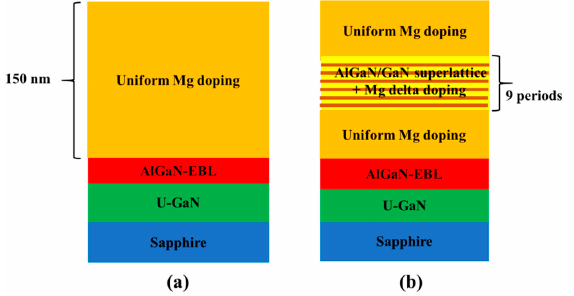
Figure 1. Structure diagrams of p-GaN: ( a ) sample A and ( b ) sample B.